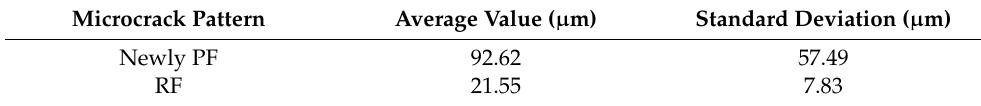
Table 1. Mean value and standard deviation of the length of the microcracks.